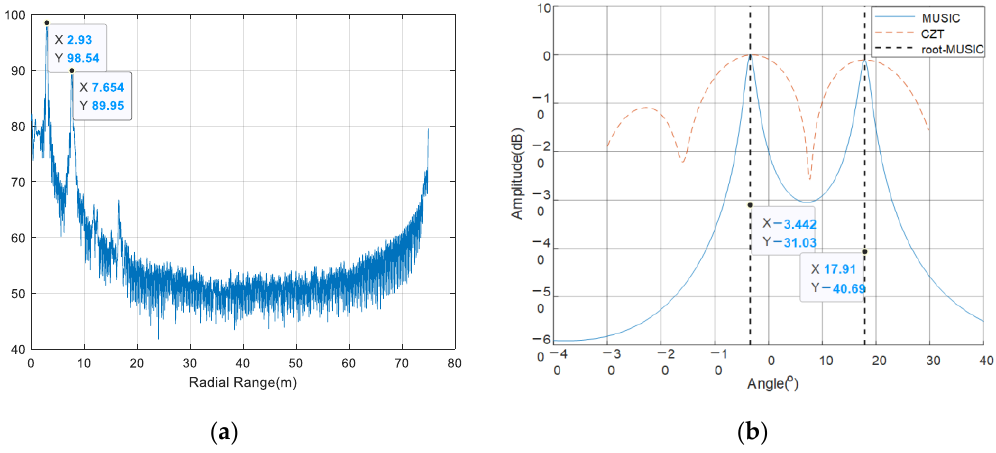
Figure 14. One-dimensional image and DOA results of the first experiment. ( a ) High resolution one-dimensional radar image. The first peak is the responses of the two trihedral reflectors separated 1.2 m in azimuth; ( b ) MUSIC, CZT and root-MUSIC can discriminate between the two reflectors.